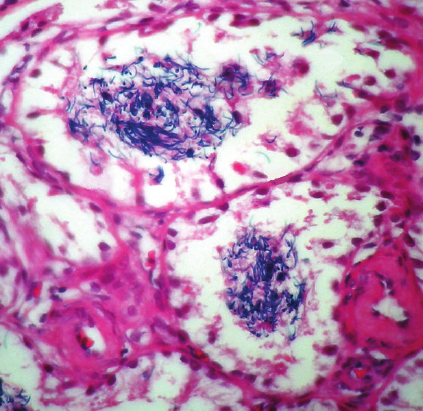
Figure 2: Seminiferous tubules of Phrynocephalus maculatus in June.